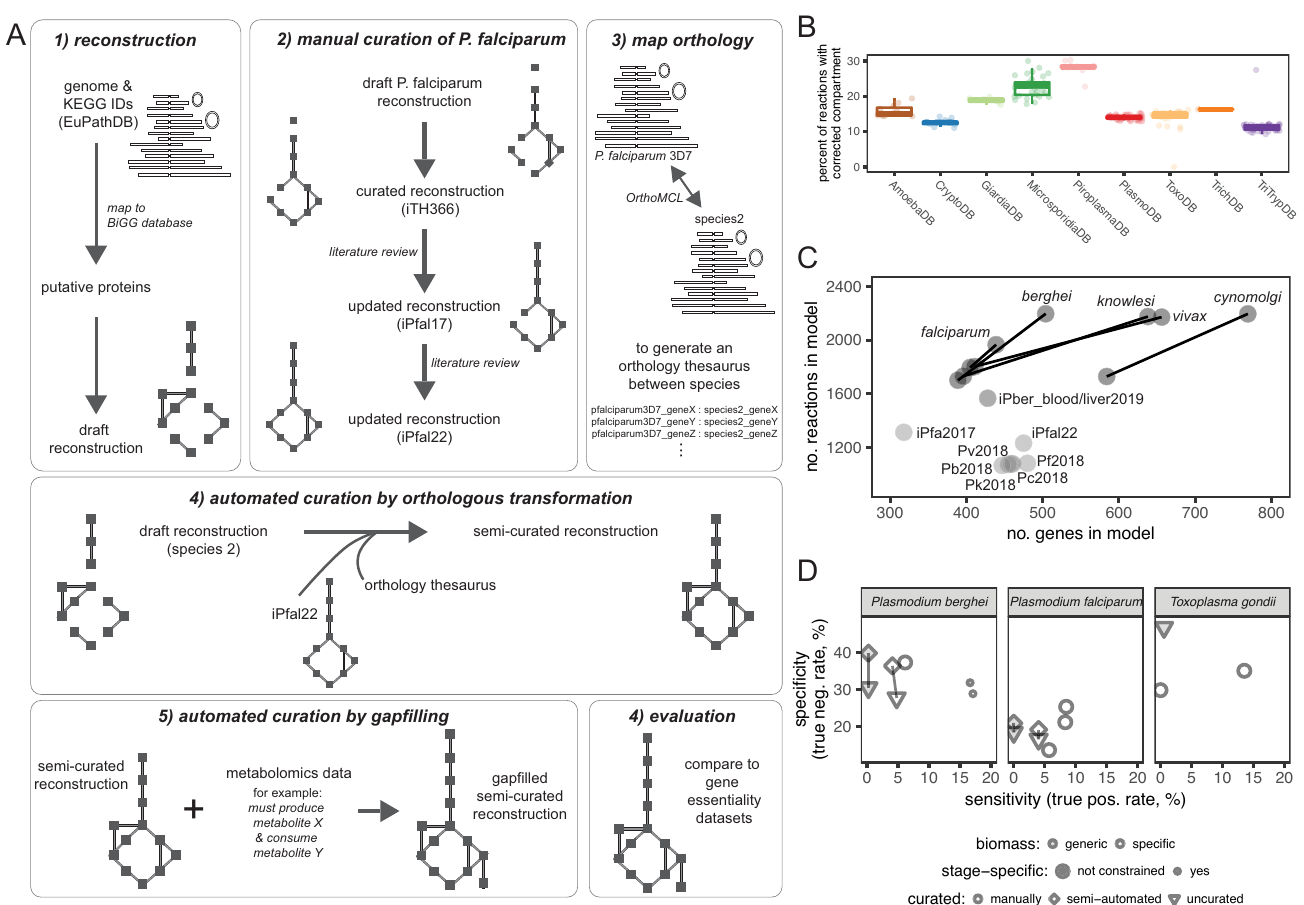
Fig 2. Building a parasite knowledgebase. Genetic data (from EuPathDB), orthology information (from EuPathDB’s OrthoMCL), and biochemical data from metabolomics studies (acquired from a literature review) were used to build our reconstructions in a multistep process; gene essentiality data was used to evaluate resultant models. (A): Reconstruction pipeline. First, de novo reconstructions are built from annotated genomes and supplemented with KEGG reaction-associated genes on the database (see Additional Information: Online Methods ). Next, we curated an existing manually curated reconstruction for P . falciparum 3D7. Third, we mapped orthologous genes so that (fourth) we could add all metabolic functions from our curated iPfal22 into the de novo reconstruction by transforming each gene-protein-reaction rule via orthology. Lastly, we performed automated curation by gapfilling reconstructions to known metabolic capabilities and to generate biomass. With the resulting reconstruction, we can compare simulations to experimental data such as gene essentiality screens. (B): Considering compartmentalization. Our approach moves a large proportion of the reconstruction’s reactions from compartments in a biochemical database to biologically- relevant compartments ( e . g . periplasm to extracellular). Thus, our de novo reconstruction approach accounts for compartmentalization, unlike many previous metabolic network reconstruction pipelines. Each model is represented by a point. Boxplots for each database denote the interquartile range with the median value at center; whiskers extend to 1.5 times the inter-quartile range (i.e. distance between the first and third quartiles) above or below the median. (C): Orthology adds information. Orthology-based curation improves reconstruction scope regarding total number of genes and reactions. These semi-curated reconstructions (each labeled dark point) are larger in scope due to the addition of reactions associated with genes added via orthologous-transformation. Semi-curated reconstructions are connected via a line to the draft uncurated reconstruction for that genome. Reconstructions are named by the associated species; Plasmodium species are labeled with species name. Light colored dots represent previously published Plasmodium reconstructions (iPfal22, from [57] and [47], iPfa2017 from [49], iPbe-blood and iPbe- liver from [58], all others from [48]). (D): Prediction accuracy. Semi-curated reconstructions (diamonds) recapitulate the biology of experimentally-facile parasites as well as published, manually-curated reconstructions (circles). We tested accuracy of model predictions from the de novo reconstruction (triangle) and the final orthology-translated and semi-curated reconstruction (diamond) for P . berghei and compared these summary statistics to the prediction accuracy generated by our well-curated iPfal22 and other previously published reconstructions [48–50,58,59]. This comparison was used to motivate our approach over de novo reconstruction building as our pipeline generates a reconstruction with greater predictive accuracy than de novo reconstruction and comparable to a well-curated